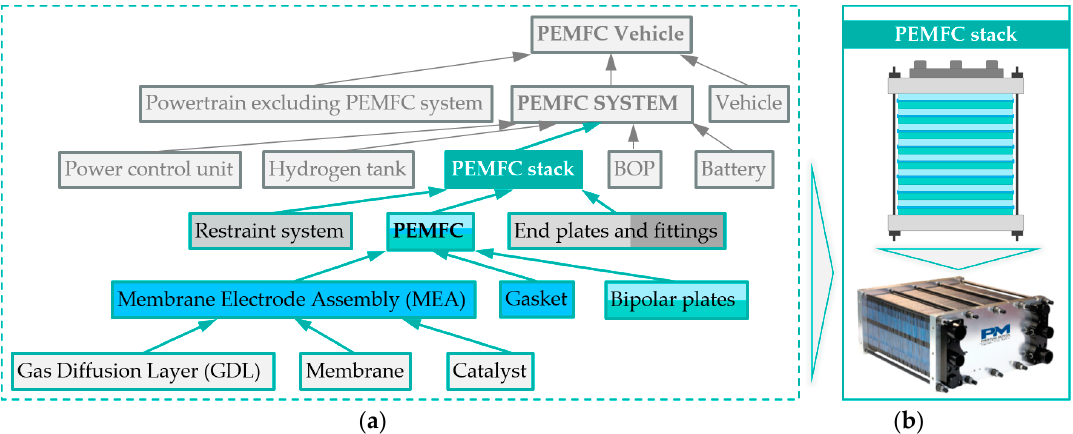
Figure 1. Polymer electrolyte membrane fuel cell (PEMFC) vehicle components and hierarchy ( a ) and PEMFC stack of Proton Motor ( b ) based on [3].